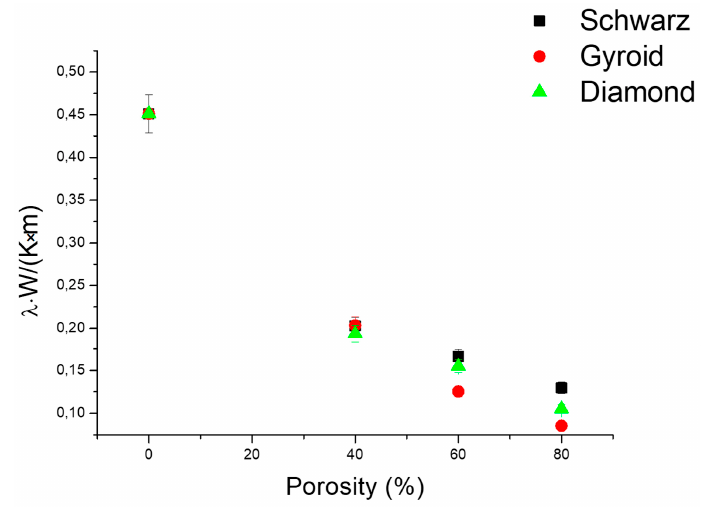
Figure 10. Effect of porosity and geometry on the effective thermal conductivity of TPU/GE porous